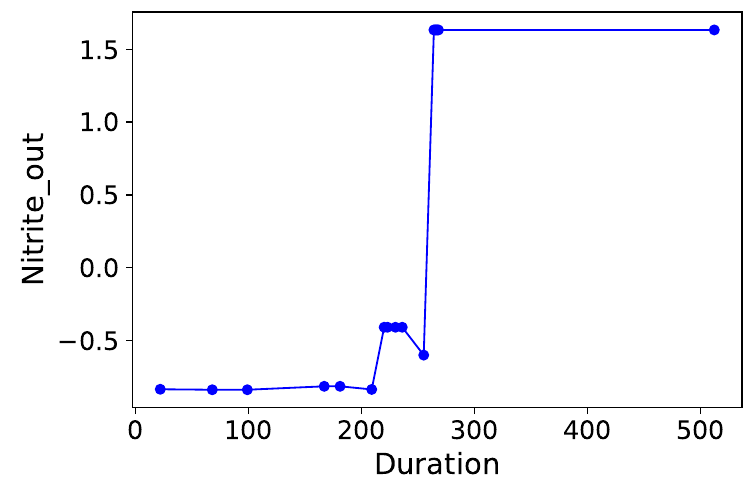
Figure A18. Normalized nitrite outlet flowrate for Reactor 2.